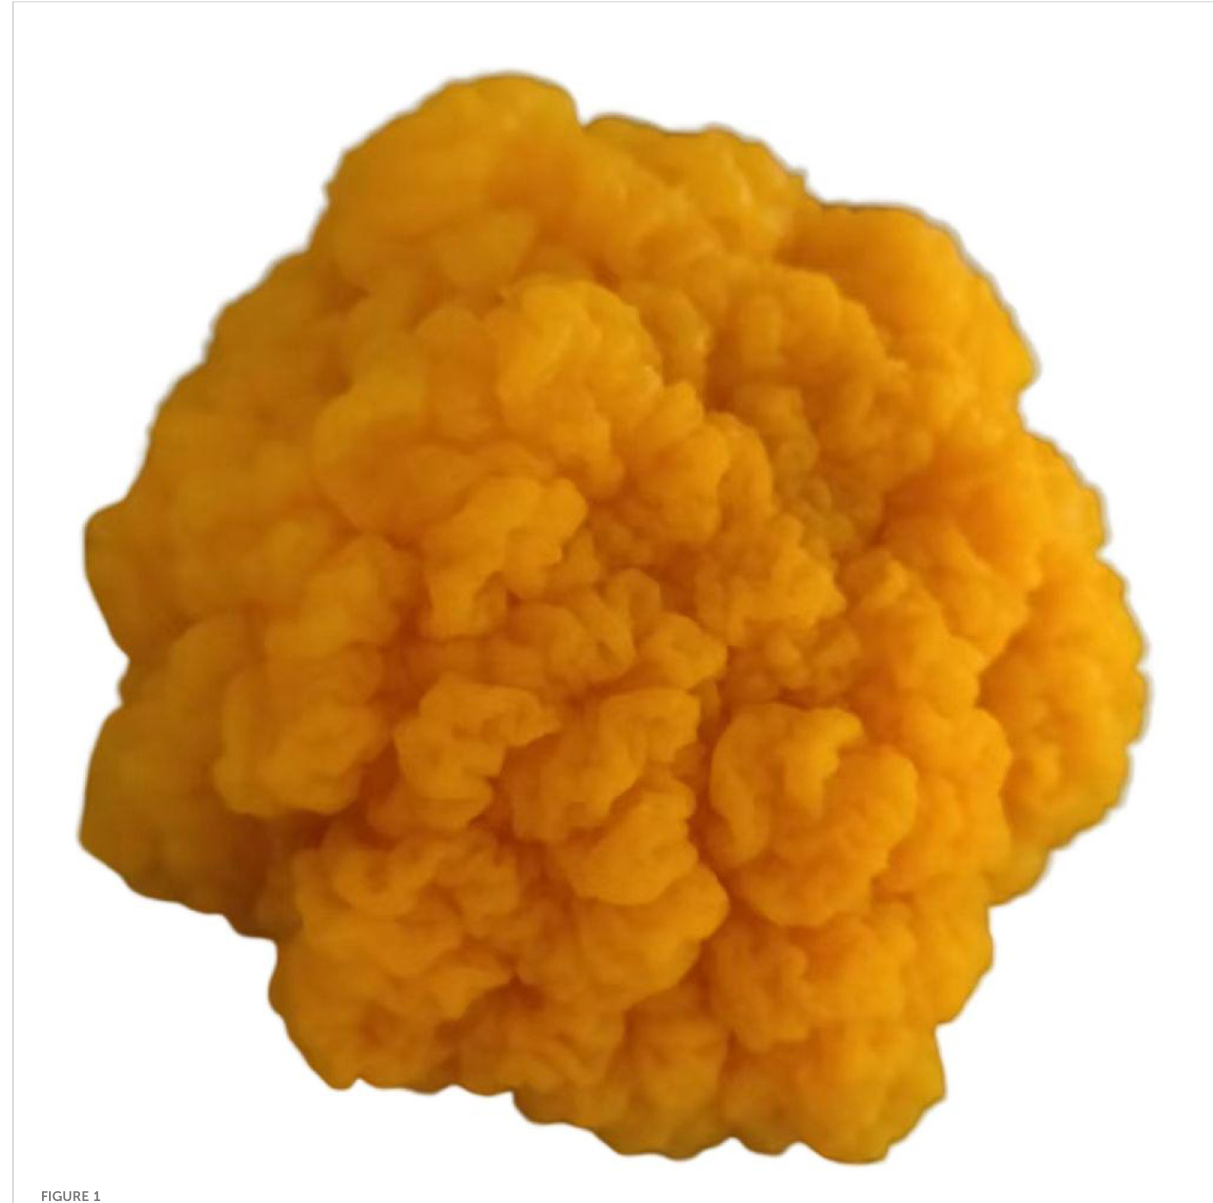
FIGURE 1 The fruiting bodies of T. aurantialba